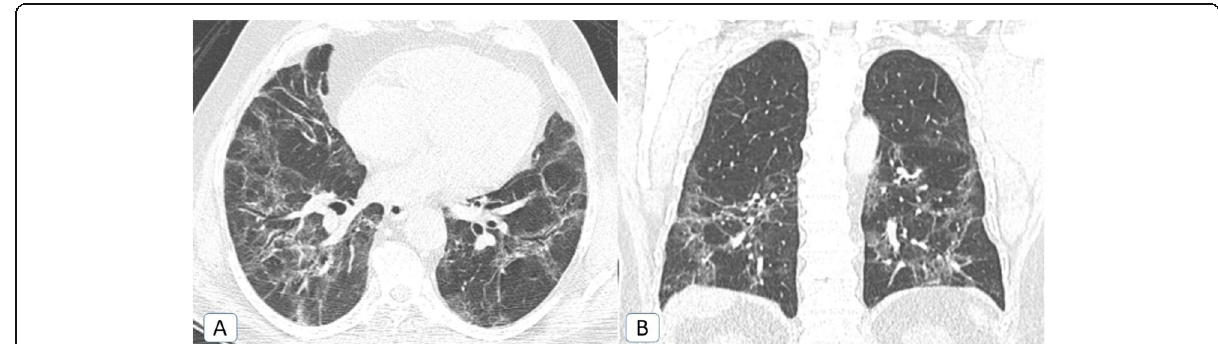
Fig. 11 Post-COVID fibrosis: a 57-year-old male COVID-19 patient. Chest CT was done 3 months after the COVID-19 infection. A Axial MPR (lung window) and B coronal MPR (lung window), showing bilateral upper and lower lobar persistent ground-glass patches and irregular fibrotic changes with parenchymal distortion and mild traction bronchiectatic